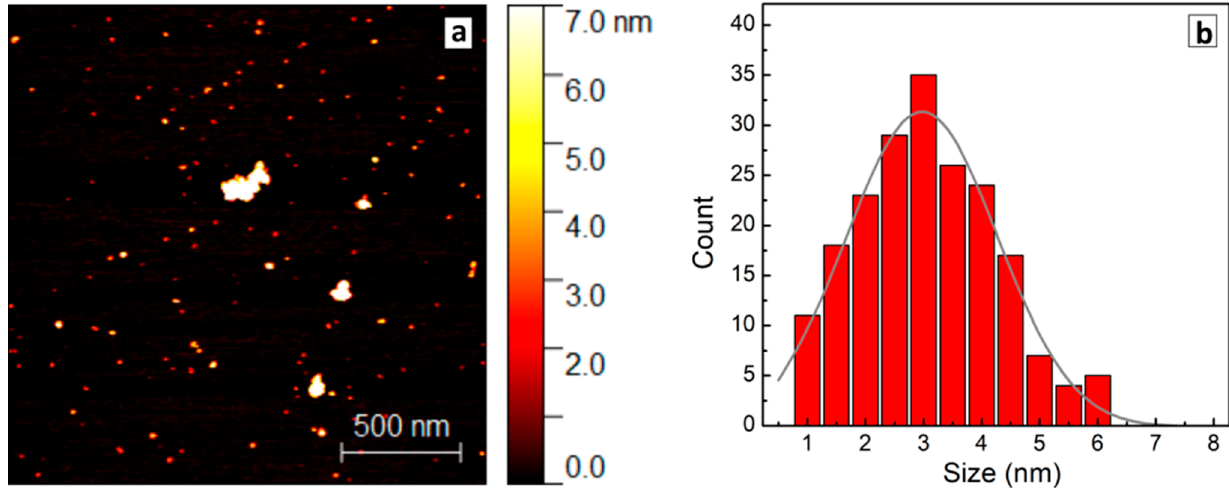
Figure 3. ( a ) AFM image of AZTS NCs on mica. ( b ) Size distribution of AZTS NCs (red bars) derived from the AFM image and fitted with a Gauss profile (solid gray line).